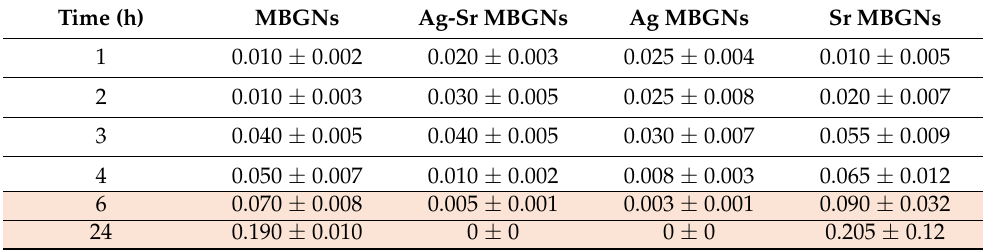
Table 2. Results of the turbidity test at optical density of 600 nm (OD 600 ) carried out on MBGNs, Ag-Sr MBGNs, Ag MBGNs, and Sr MBGNs after 1, 2, 3, 4, 6, and 24 h of incubation (each